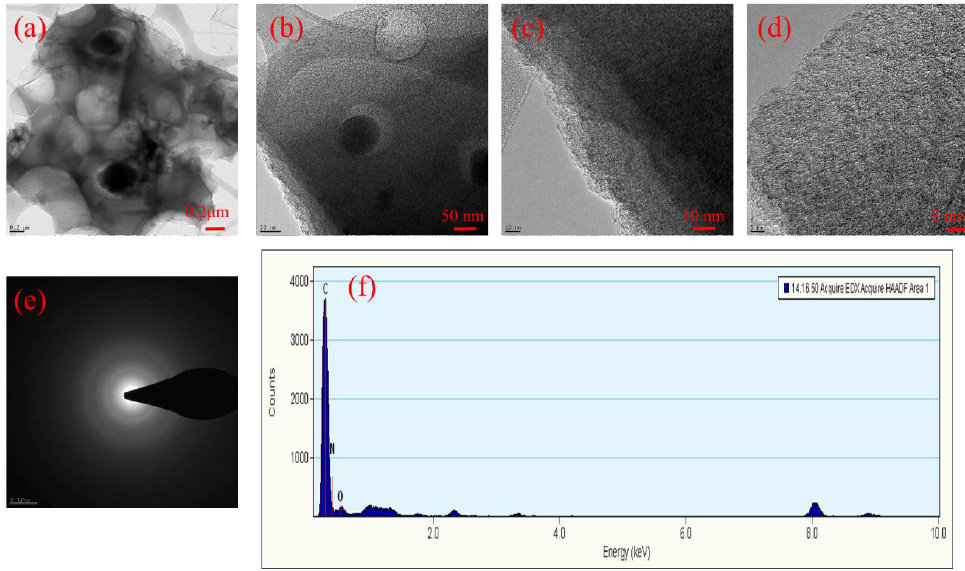
Figure 6. TEM image with corresponding SAED pattern and EDX of ( a – f ) HPCPC-800.